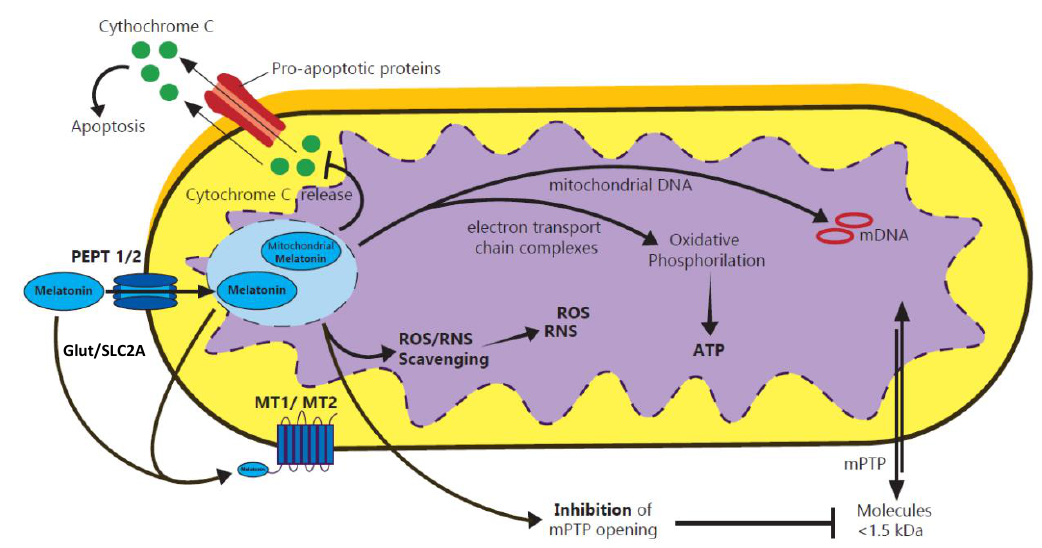
Figure 1. The roles of melatonin within the mitochondria. Melatonin is transported into mitochondria through PEPT1 / 2 oligopeptide and Glut / SLC2A transporters, but it is also synthesized within mitochondria [12,13]. Melatonin lowers the formation of free radicals and protects ATP synthesis at the mitochondrial level. It scavenges free oxygen (ROS) and nitrogen (RNS) reactive species, by preventing mitochondrial apoptosis and disruption of the electron transport chain. Melatonin interacts with MT1 and MT2 melatonin receptors, inhibits pro-apoptosis protein synthesis, and the subsequently cytochrome C leakage at the level of the membrane. It also protects mitochondrial DNA and prevents the opening of the mitochondrial permeability transition pore (mPTP) [13].